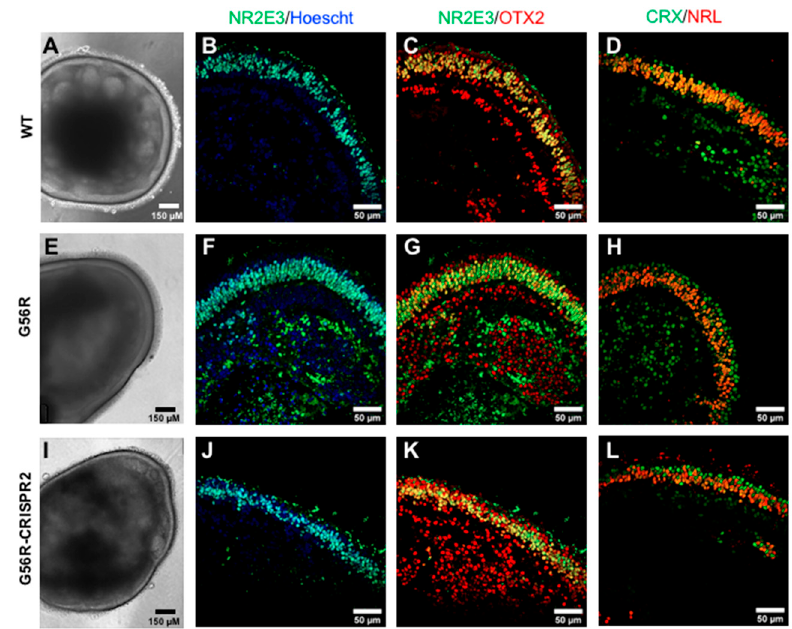
Figure 6. Retinal differentiation potential following NR2E3 allele knockout. Bright-field images of WT ( A ), G56R ( E ), and G56R-CRISPR2 ( I ) iPSC-derived retinal organoids at 180 days of differentiation. IF analysis of NR2E3 expression (in green) in WT ( B ), G56R ( F ), and G56R-CRISPR2 ( J ) retinal organoids; nuclei labelled in blue. NR2E3 expression is localized to the photoreceptor nuclei, which form an outer layer, corresponding to the outer nuclear layer (ONL), in the organoid. Colocalization studies of NR2E3 (in green) and OTX2 (in red) expression in WT ( C ), G56R ( G ) and G56R-CRISPR2 ( K ) retinal organoids. NR2E3 is restricted to the rod nuclei whereas OTX2 also labels the more peripheral cone nuclei, as well as retinal cells situated on the inner side of the ONL. Colocalization studies of CRX (in green) and NRL (in red) expression in WT ( D ), G56R ( H ), and G56R-CRISPR2 ( L ) retinal organoids. NRL expression is restricted to rod nuclei, whereas CRX also labels the cone nuclei situated on the outer rim of the